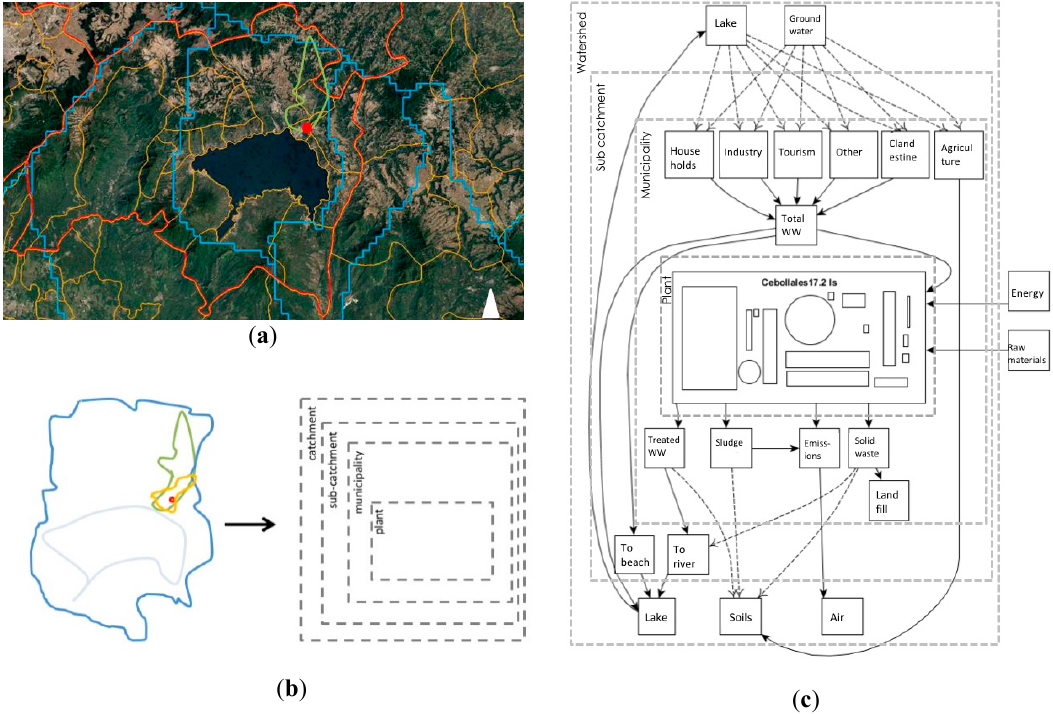
Figure 3. ( a ) A first boundary explorations map for the Panajachel case, showing different scales of analysis that were initially found to be of interest: the plant scale (red dot), the subcatchment (light green), the municipality (yellow), the watershed (blue) and the province (orange). The large water body in the center is the Atitlan Lake. ( b ) The abstraction of “real-world” boundaries into boundaries for the modeling process. ( c ) The system model for the Panajachel case, showing the systems components in the scale they (mostly) operate in.